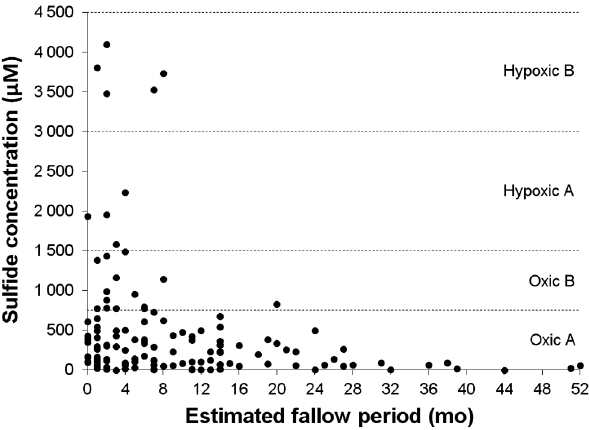
Fig. 5. Relationship between the average sulfide concentra- tion in annual regulatory monitoring at fallowed farms and the length of the fallow period (time between the end of har- vesting at the date of monitoring, to the nearest month), 2002 to 2009. There were 137 monitoring events at farms holding no fish during this period; estimates of the fallow pe- riod were available for 131 of these events (including 38 at farms that had been fallow >12 mo), representing 79 differ- ent farms. A fallow period of 0 mo indicates <2 wk between harvesting and